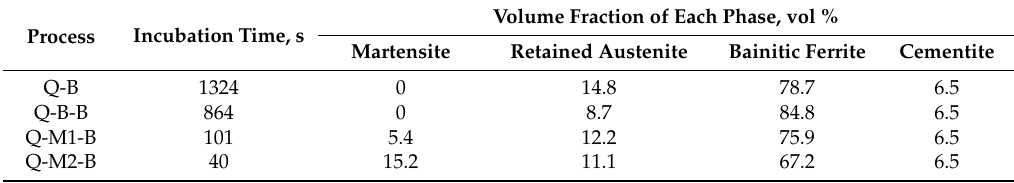
The incubation time and microstructure parameters for specimens treated by different